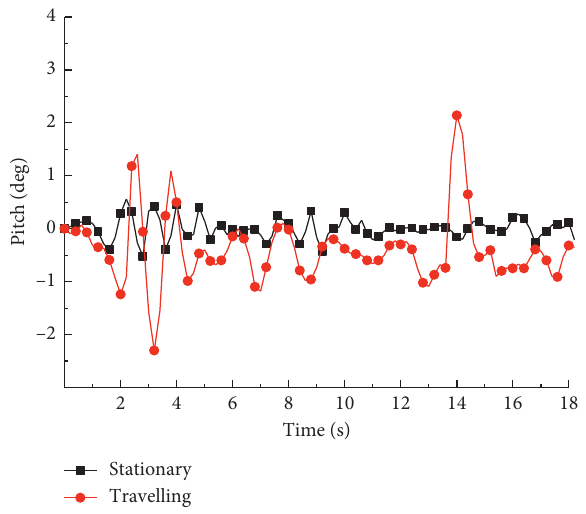
Figure 11: Time history curve of ship pitch in landslide section.